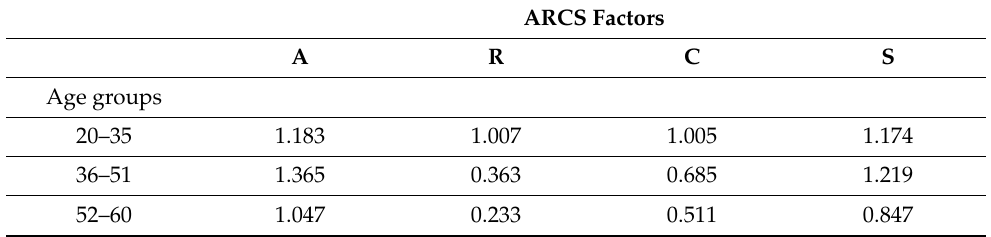
Table 6. Values of Cohen’s d measure of effect, per ARCS factor and per age group: the highest effect of training was for the age 20–35 and, for all ages, for the factors A and S. ARCS